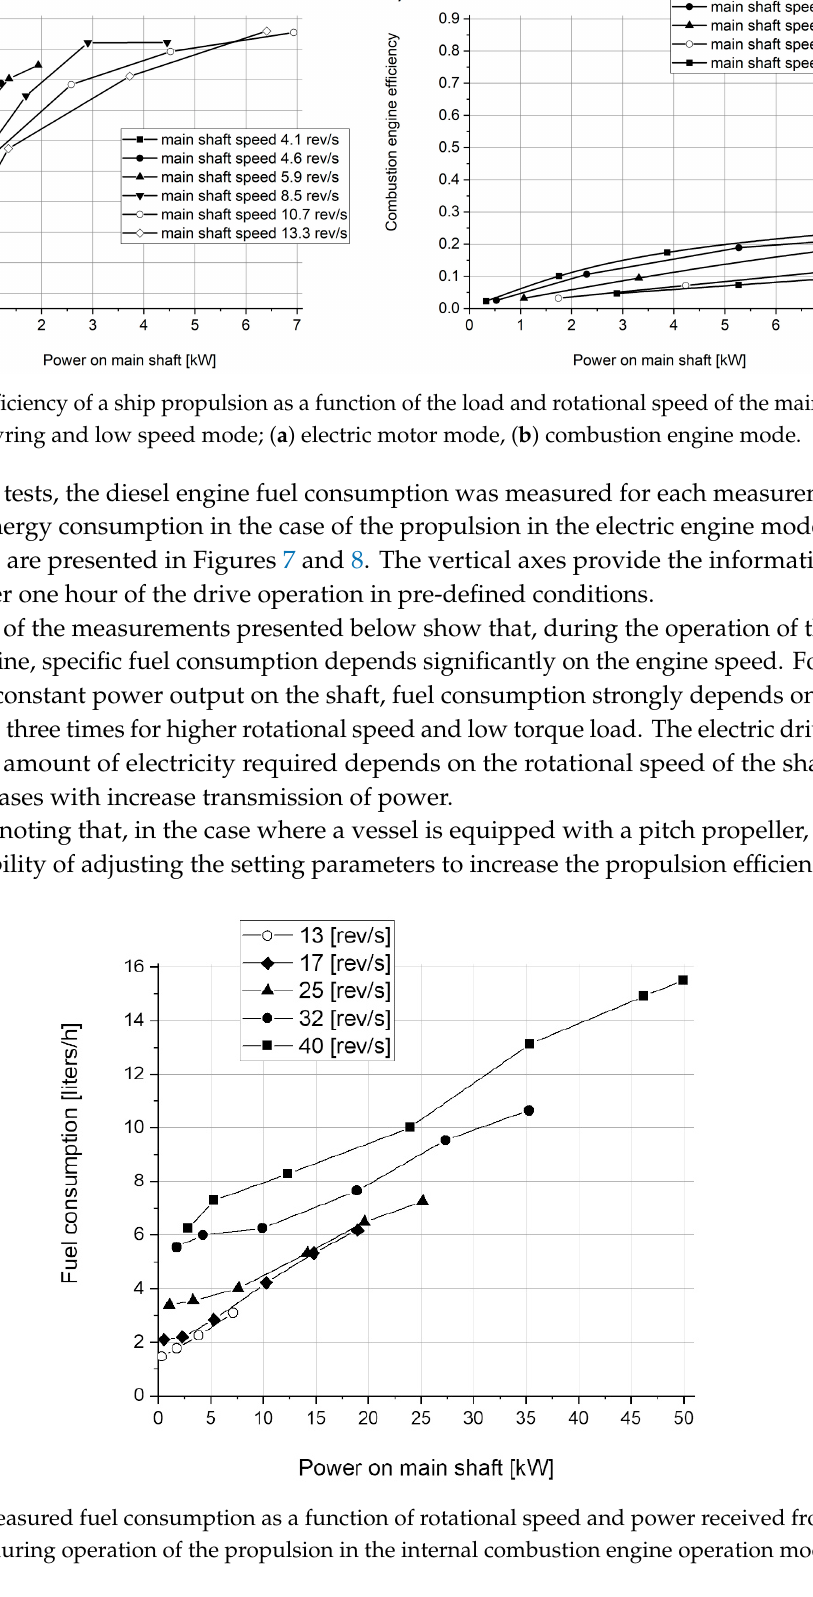
Figure 5. Measured efficiency in the internal combustion engine operation mode with a dedicated reduction gear as a function of the load and rotational speed of the main shaft.